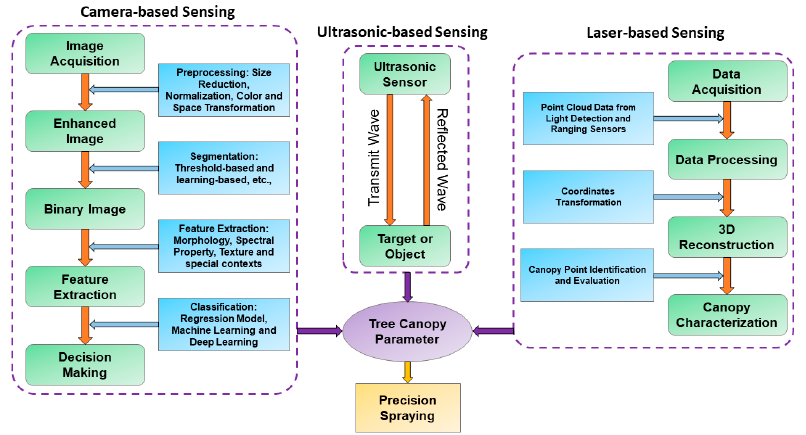
Figure 3. Typical flow-chart for canopy parameter measurement using different sensing systems to support precision spraying.